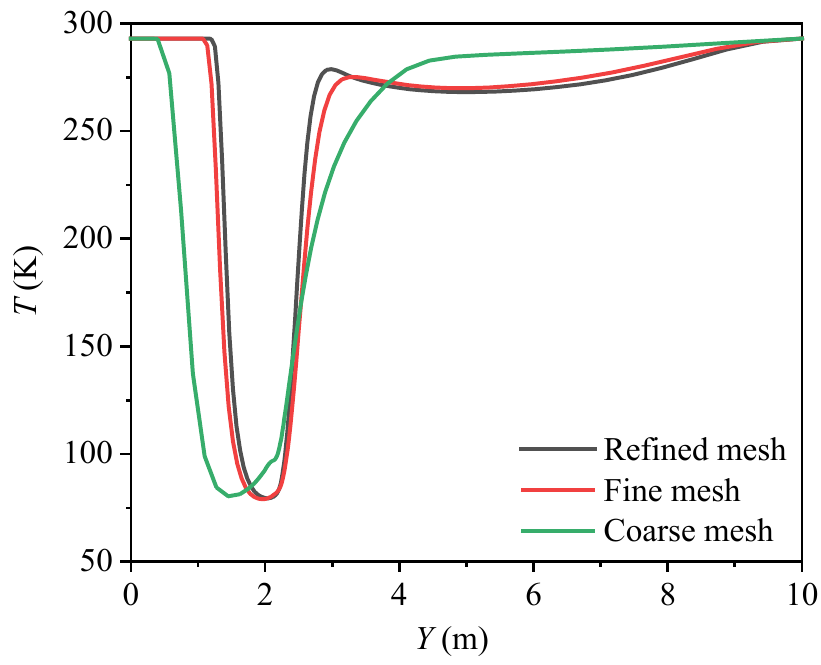
Figure 2. Temperature distribution with different grid numbers ( t = 100 s, X = 0, Z = 1.4 m).